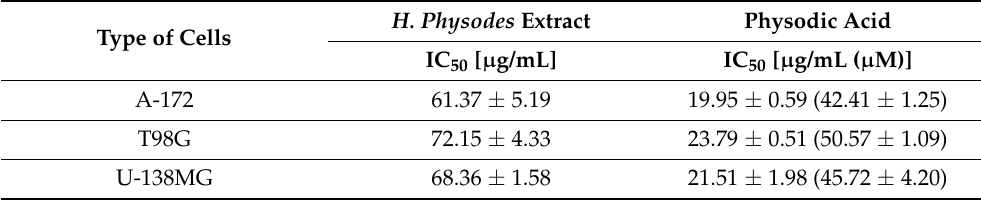
Table 1. The IC 50 of cells viability after Hypogymnia physodes extract or physodic acid exposition. Type of